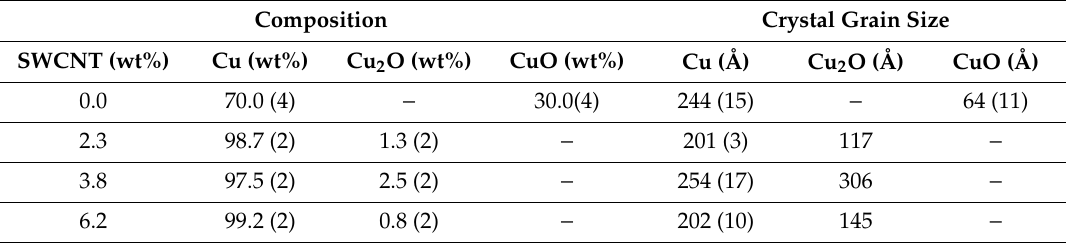
Table 4. Chemical composition and crystal grain size as determined by XRD of Cu–SWCNT composites electrodeposited at a bath temperature of 60 °C. 1 .